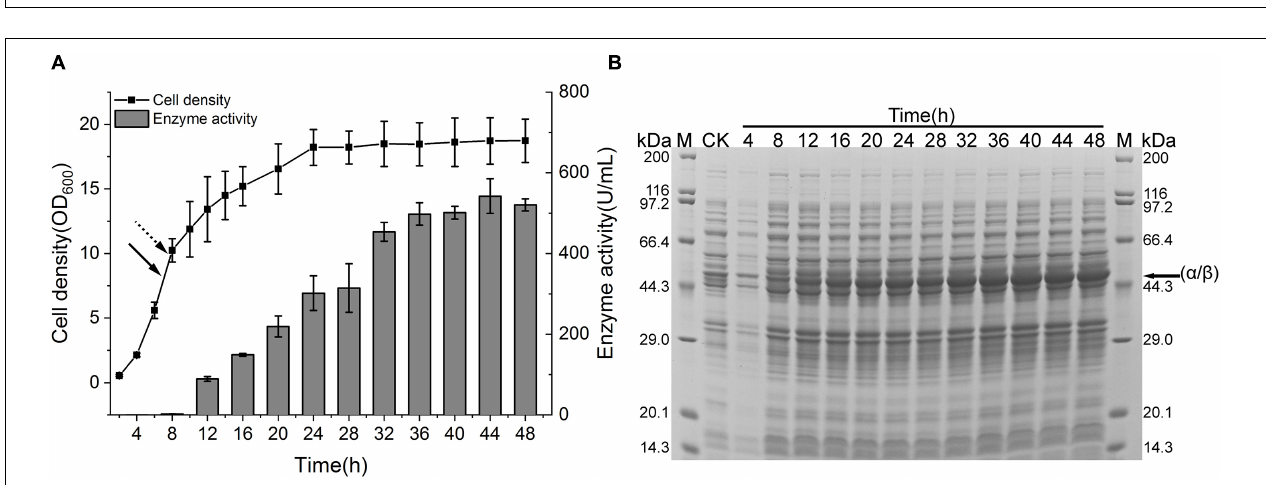
FIGURE 5 | NHase expression by CIES and CIES 2.0. (A) Cell density of NHase expression strains at different concentrations of Co(II). (B) Enzyme activity of NHase expression strains at different concentrations of Co(II). All error bars in figures presented root-mean-square deviation of three separate experiments.